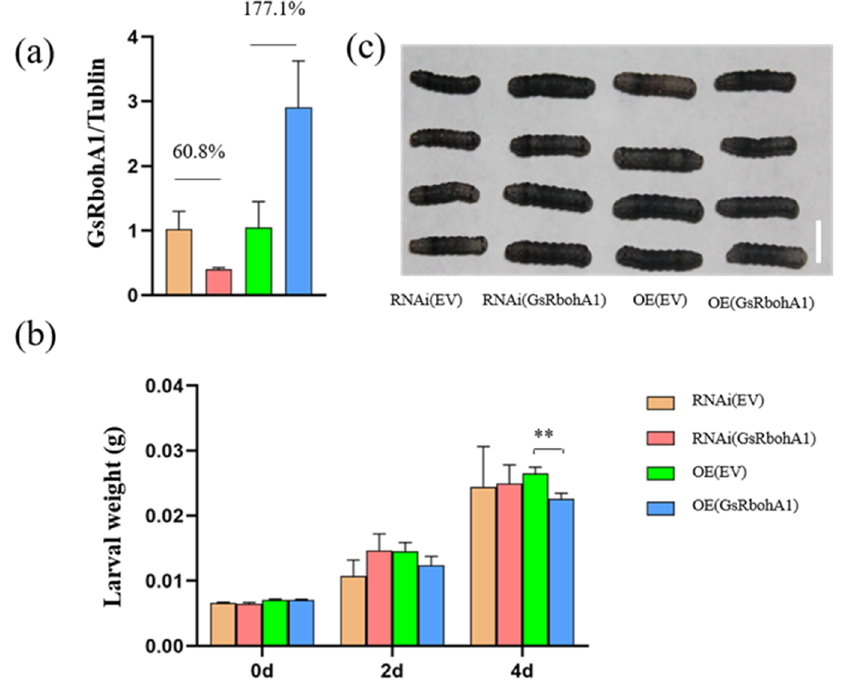
Figure 5. Functional characterization of GsRbohA1 . ( a ) The transcriptional level of RbohA1 in hairy roots overexpressing GsRbohA1 (OE ( GsRbohA1 )), RNA interference for GsRbohA1 (RNAi ( GsRbohA1 )), the overexpression empty vector (OE (EV)) and the RNA interference empty vector (RNAi (EV)). The error bars represent standard deviations, n = 3. ( b ) larval weight of common cutworm (CCW) before feeding and at 2 days and 4 days after feeding on soybean hairy roots. Error bars represent the standard deviations, n ≥ 12, and statistical significance was detected by a two-tailed t test. ** p < 0.01. ( c ) CCW larvae feeding on soybean hairy roots for 4 days; the scale bar represents 1 cm.